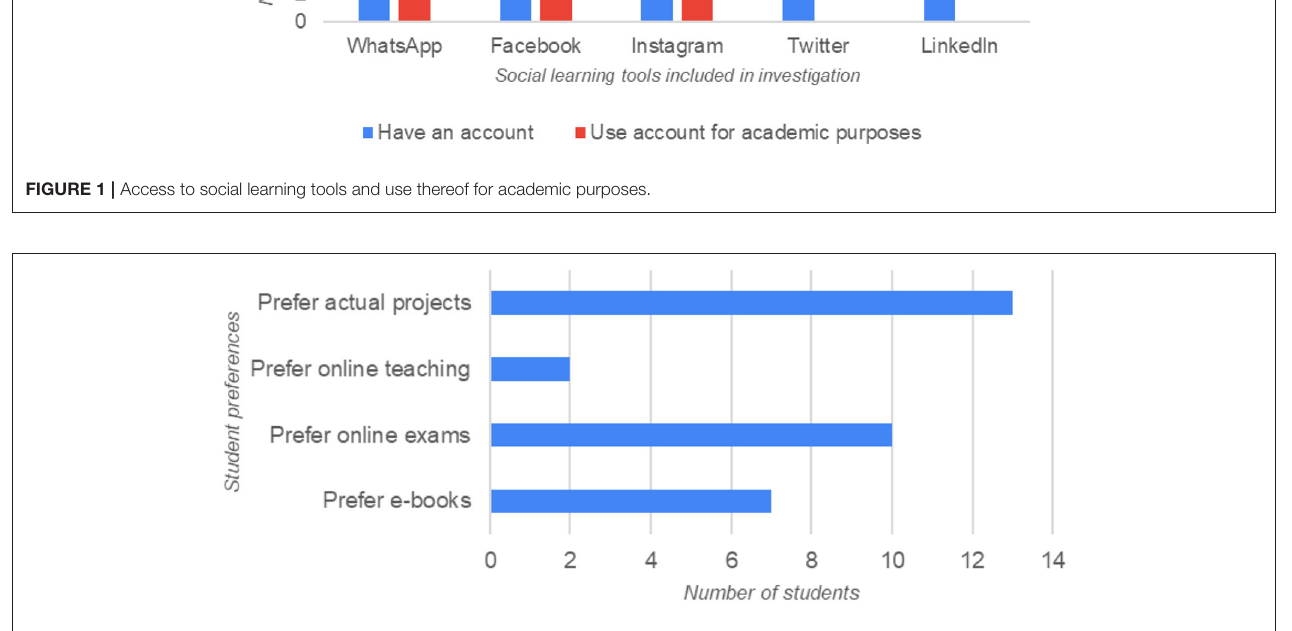
FIGURE 2 | Preference to online learning approaches.